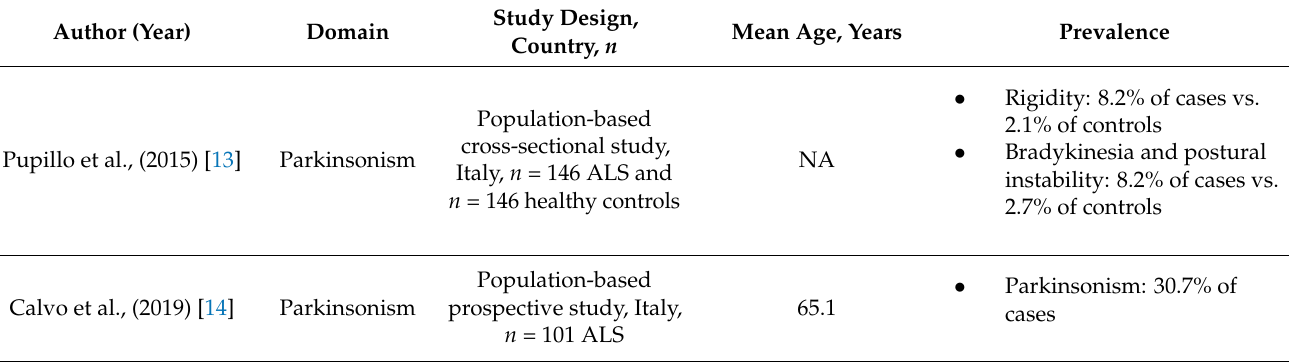
Table 1. Population-based studies of parkinsonian features in amyotrophic lateral